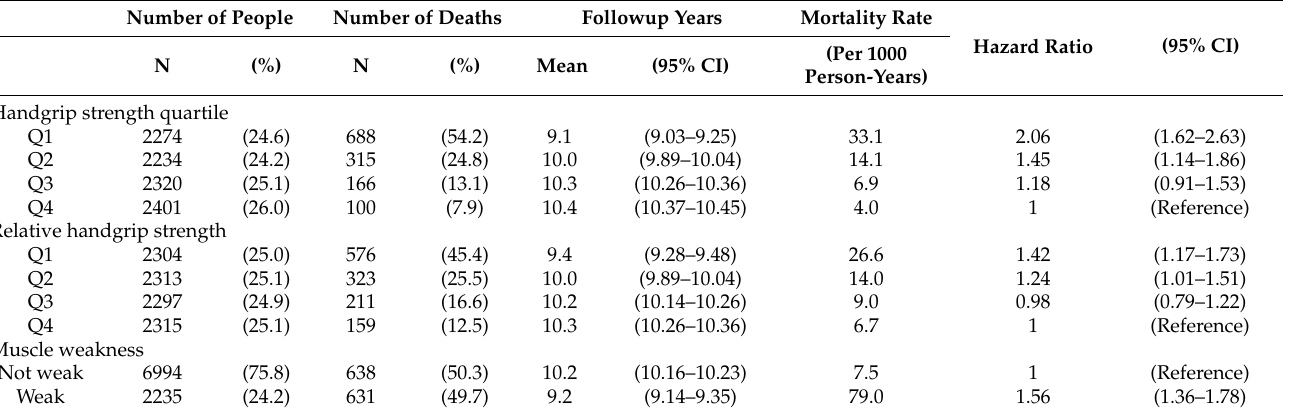
Table 3. Results for the associations of the handgrip strength and weakness group on time to all-cause